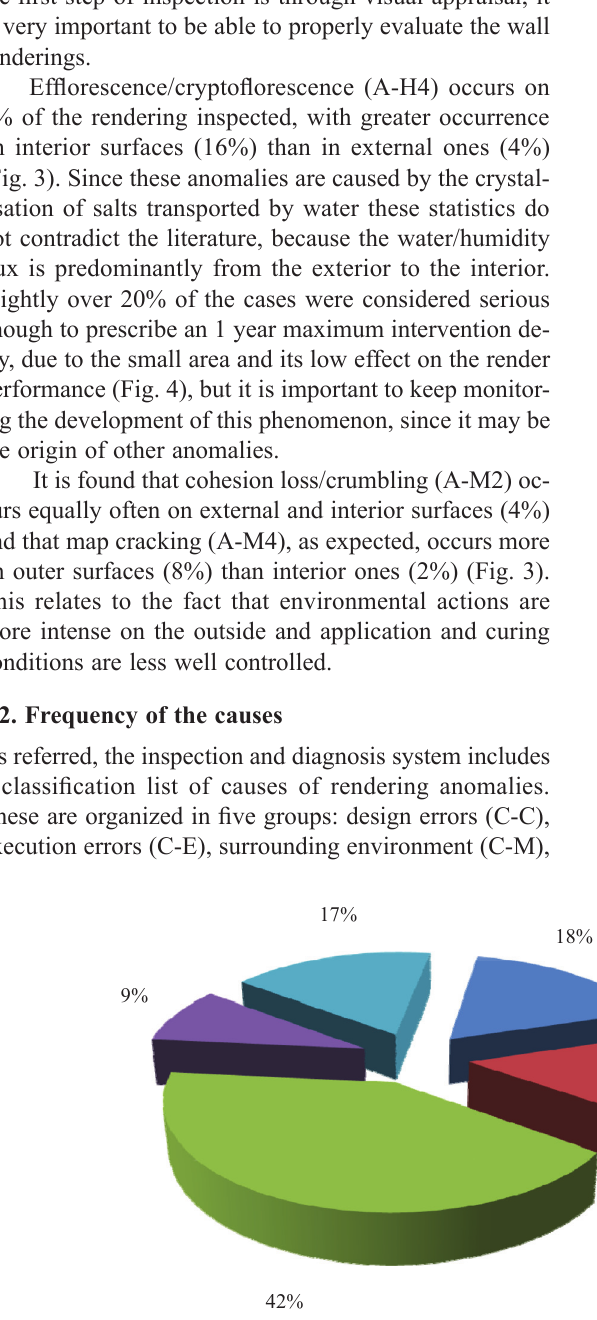
Fig. 6. Relative contribution of each group of causes to the anomalies detected